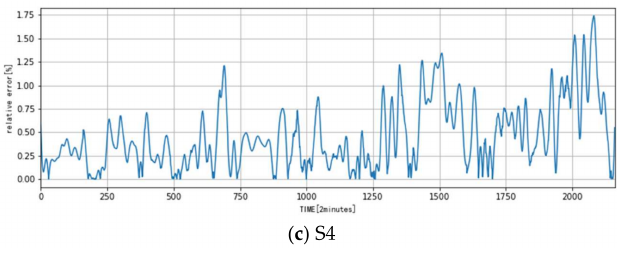
Figure 8. Relative error of predicted and experimental data.